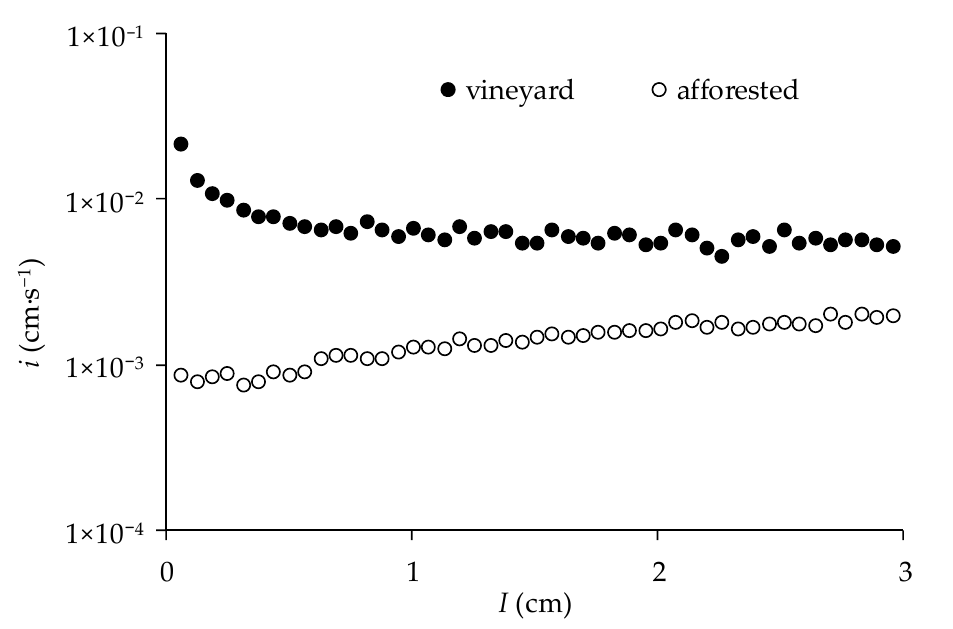
Figure 4. Dependence of infiltration rate ( i ) on the extent of infiltration ( I ). The points show the average values of four independent infiltration measurements in the vineyard and a ff orested research